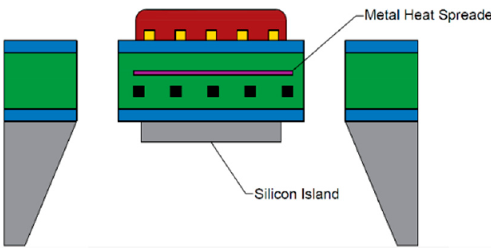
Figure 7. Silicon island and metal heat spreader application on a microhotplate.